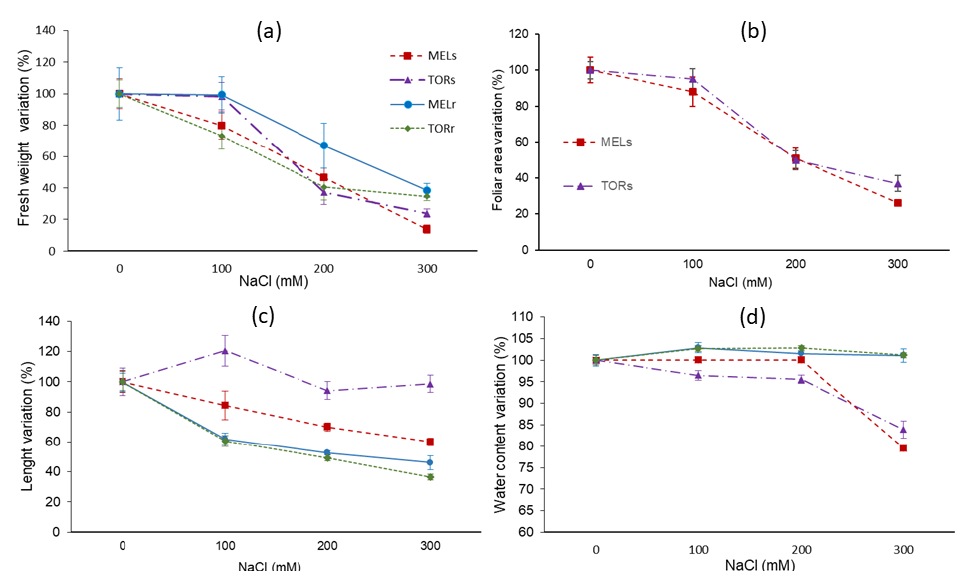
Figure 2. Variation of growth parameters in S. melongena (MEL) and S. torvum (TOR), in roots (MELr and TORr), and shoots (MELs and TORs), after 25 days of salt treatments at the indicated NaCl concentrations: ( a ) fresh weight of roots and shoots; ( b ) foliar area; ( c ) length of roots and stems; and ( d ) water content of roots and shoots. Values displayed are percentages of the corresponding controls (0 mM of NaCl), taken as 100%; absolute values are shown in Table S1.